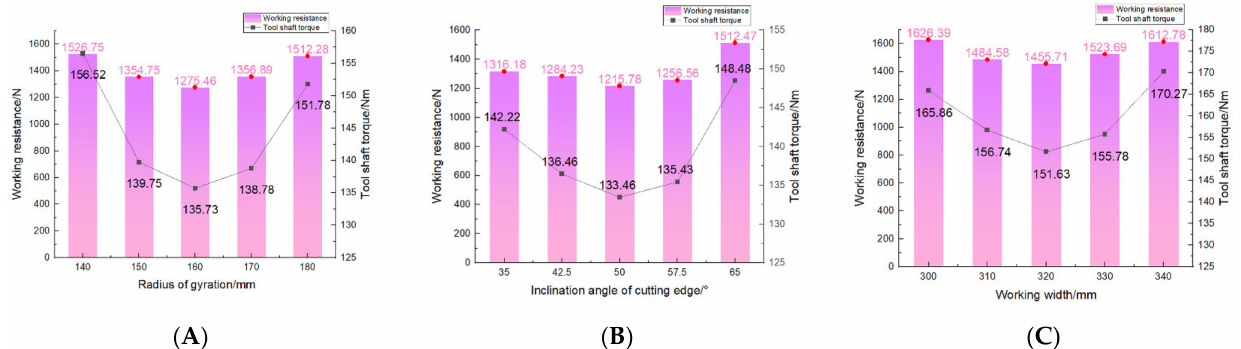
Figure 15. Results of single-factor test on evaluation indicators. ( A ) Results of single-factor test on radius of gyration R . ( B ) Results of single-factor test on inclination angle of cutting edge β . ( C ) Results of single-factor test on working width L